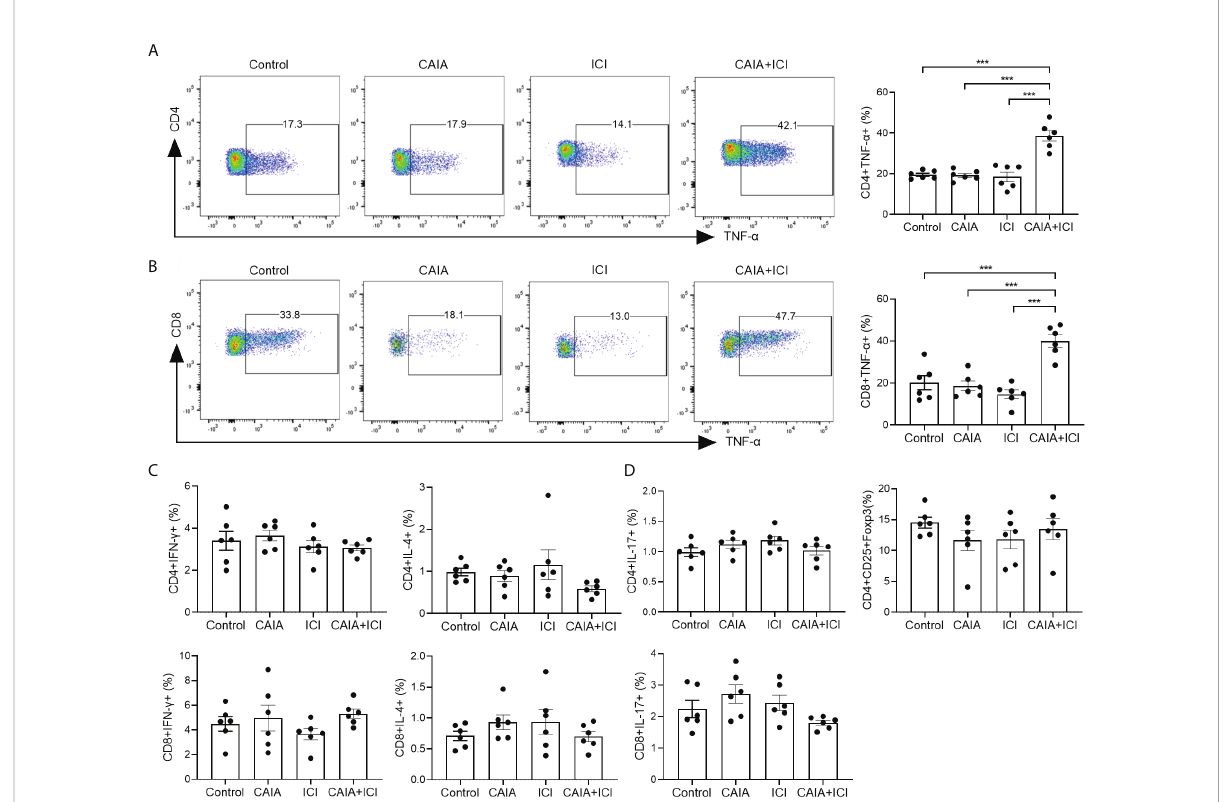
FIGURE 2 Flow cytometry analyses of different subsets of functional splenic T cells in mice. Splenic mononuclear cells were isolated from individual groups of mice and stained with the indicated fl uorescent antibodies. Some cells were fi xed, permeabilized and intracellularly stained with the indicated antibodies. The frequency of different sunsets of splenic functional T cells was characterized by fl ow cytometry. The cells were gated on living cells and then on CD4 + or CD8 + T cells. The data were analyzed Flowjo software. (A, B) Representative fl ow charts (left) and quantitative results (right) of splenic TNF- a secreting CD4 + or CD8 + T cells in mice. (C, D) Quantitative analysis of the frequency of the indicated functional splenic T cells. Data are representative fl ow charts or presented as means ± SEM (n=6) of each group of mice from two separate experiments. Statistical signi fi cance was tested by one-way ANOVA and post hoc Bonferroni test. *** p < 0.001.